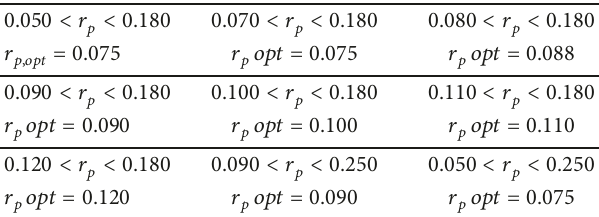
Figure6:Numberofthereachablepointswhoseconditionnumbers are under 1000. Table 1: Optimization of mobile platform diameter for various range